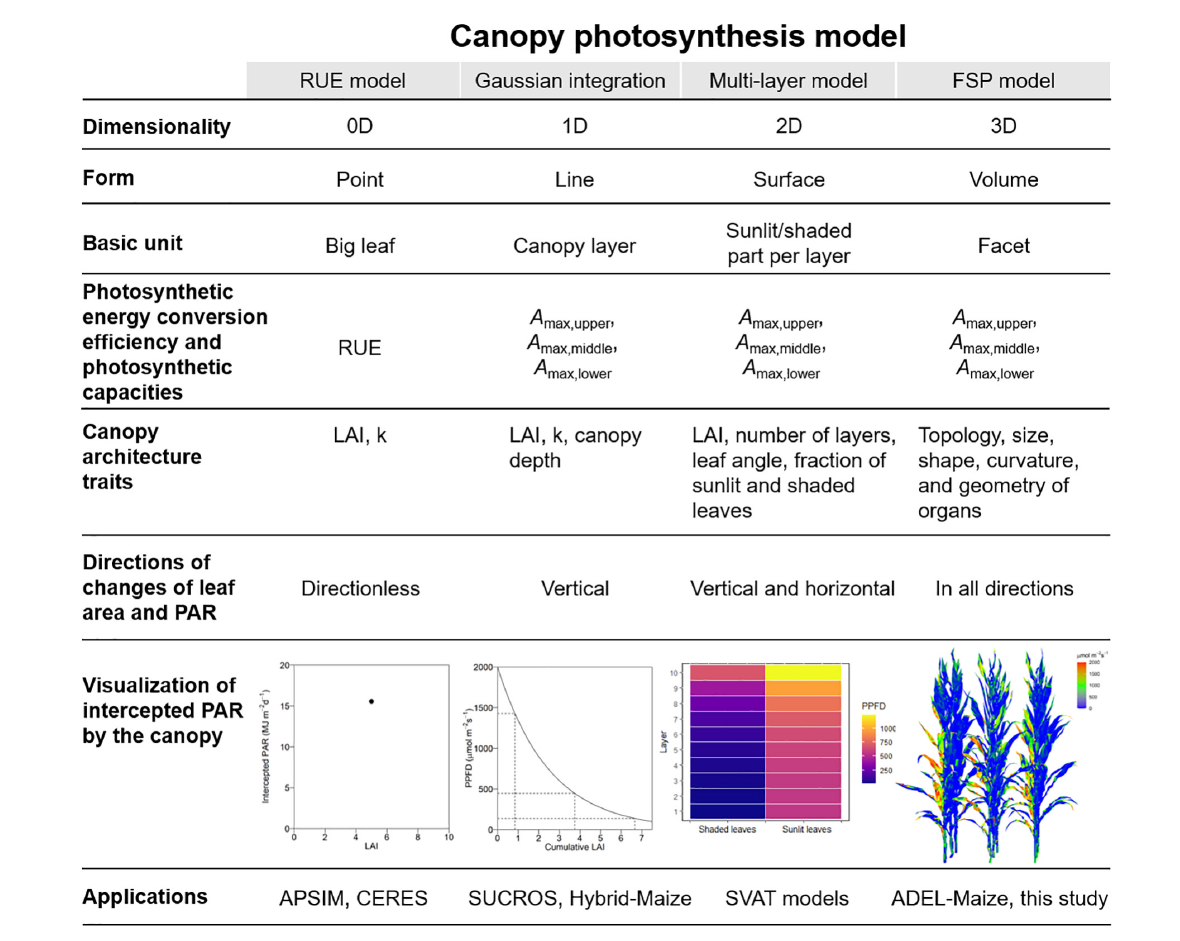
FIGURE1 The comparison of the form, basic unit, photosynthetic energy conversion efficiency and photosynthetic capacity, canopy architecture traits, direction of canopy leaf area and PAR changes, visualization of intercepted PAR by canopy, and applications between canopy photosynthesis models with different dimensions ranging from 0D to